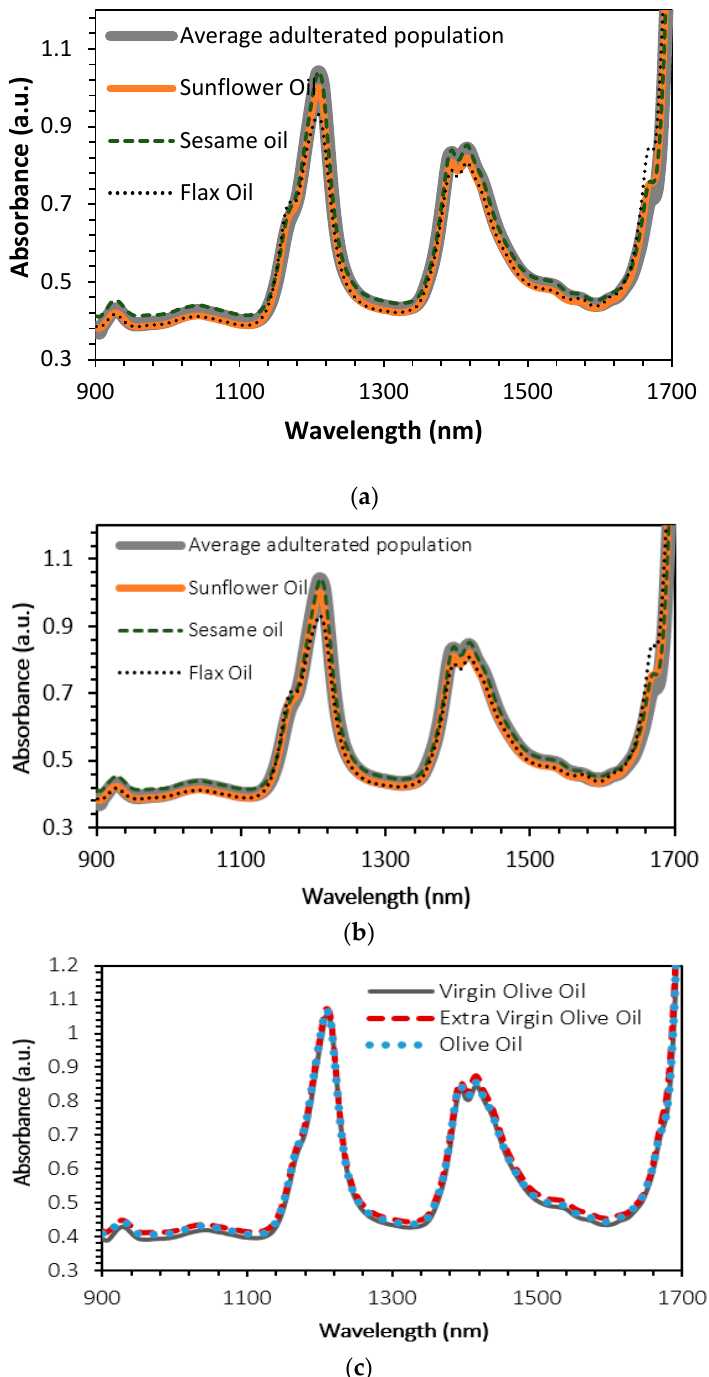
Figure 12. Raw spectra of all pure oils: ( a ) raw spectra of all mixtures, ( b ) seed oils and average spectrum of all adulterated samples, and ( c ) olive oils spectra.